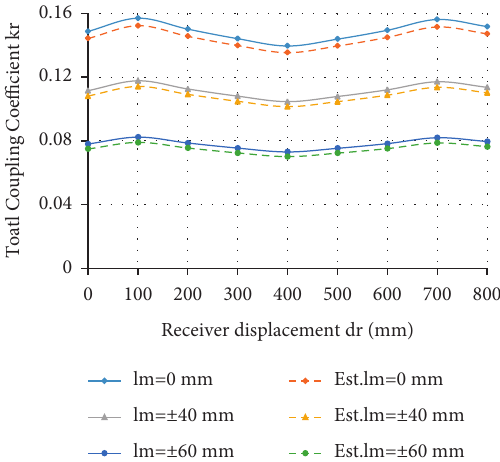
Figure 3: Simulation and estimation result of the total coupling coefficient. Table 1: The self-inductance and mutual-inductance values of the transmitters and receiver.